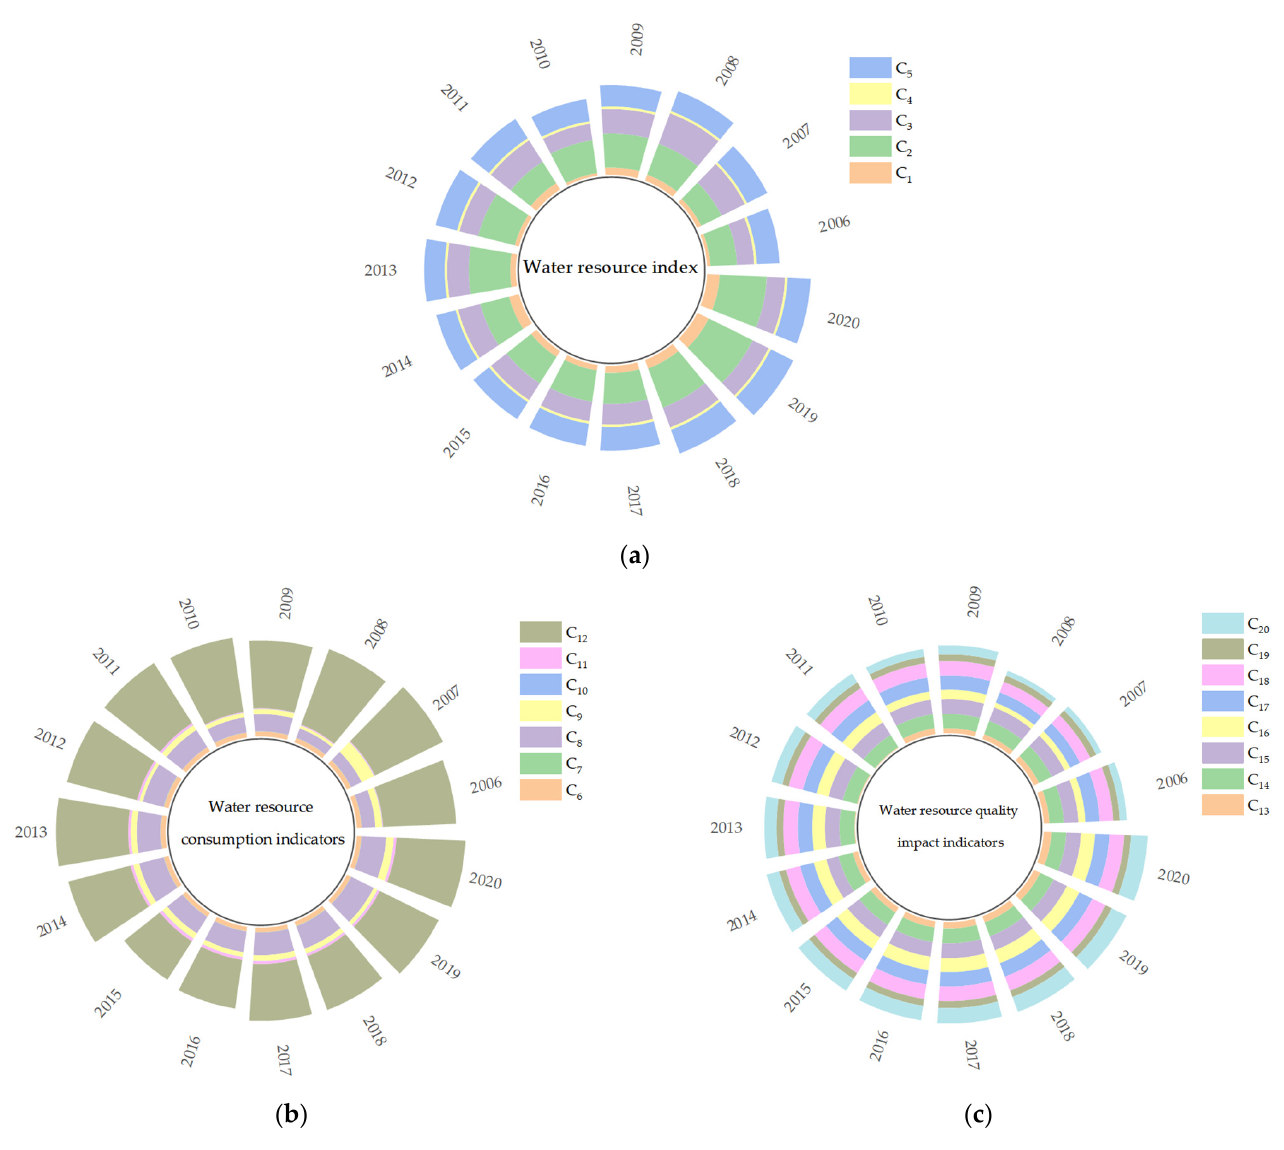
Figure 2. Factors affecting the water environment carrying capacity of Harbin City: ( a ) is a numerical plot of water quality indicators, ( b ) is a numerical plot of water consumption indicators, and ( c ) is a numerical plot of water quality impact indicators.